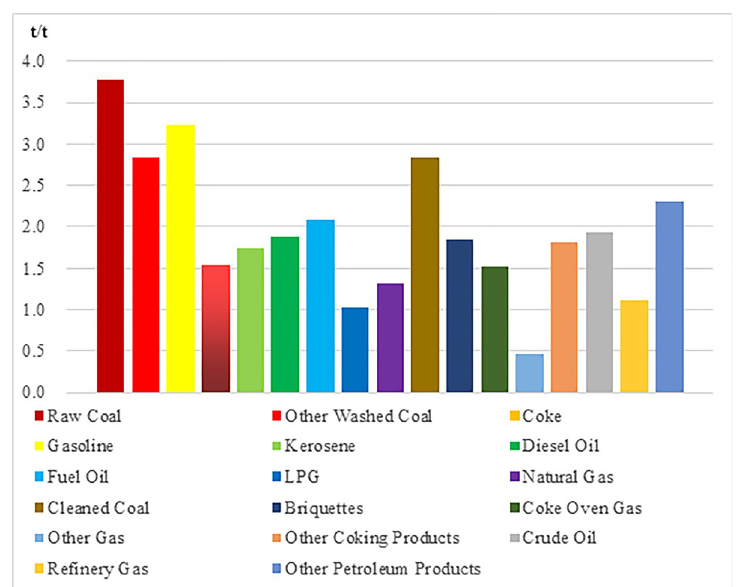
Fig 3. The carbon emission sensitivity of each energy